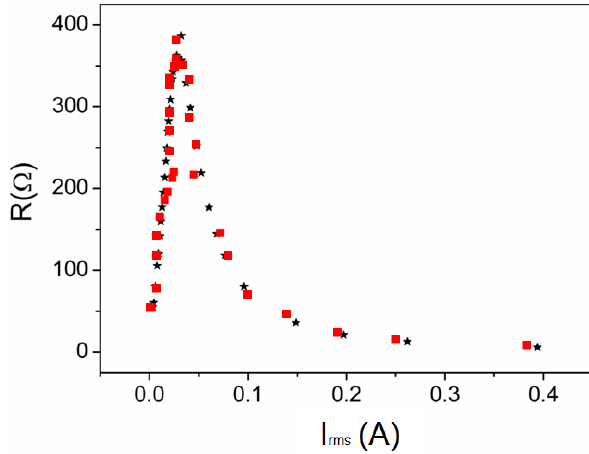
Figure 3. Results at 20 kHz. IR  curve. Experiment (    ) and 2D simulation (    rms